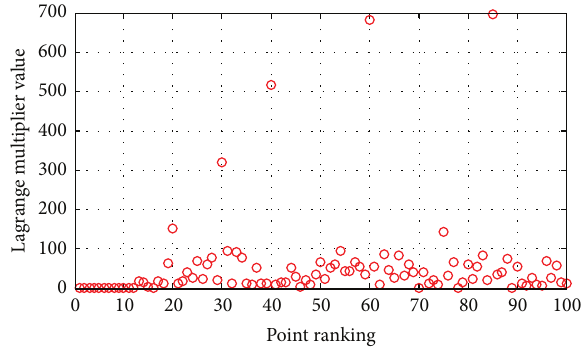
Figure 6: Lagrange multiplier value.